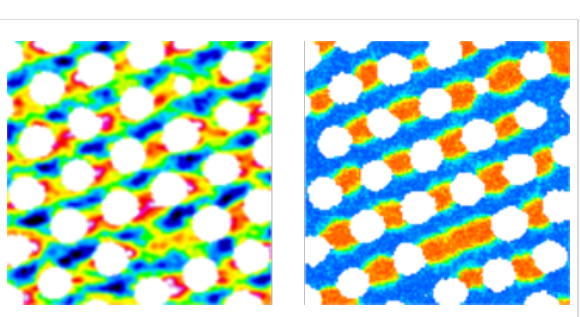
Figure 13: Left image: XMCD image of a 43 nm thin FeGd film with antidot diameter of 165 nm and centre-to-centre spacing of 200 nm. Right image: Results of a simulation of the same film geometry at T = 300 K. The saturation magnetisation was increased by 40% and the anisotropy was decreased by 30%,